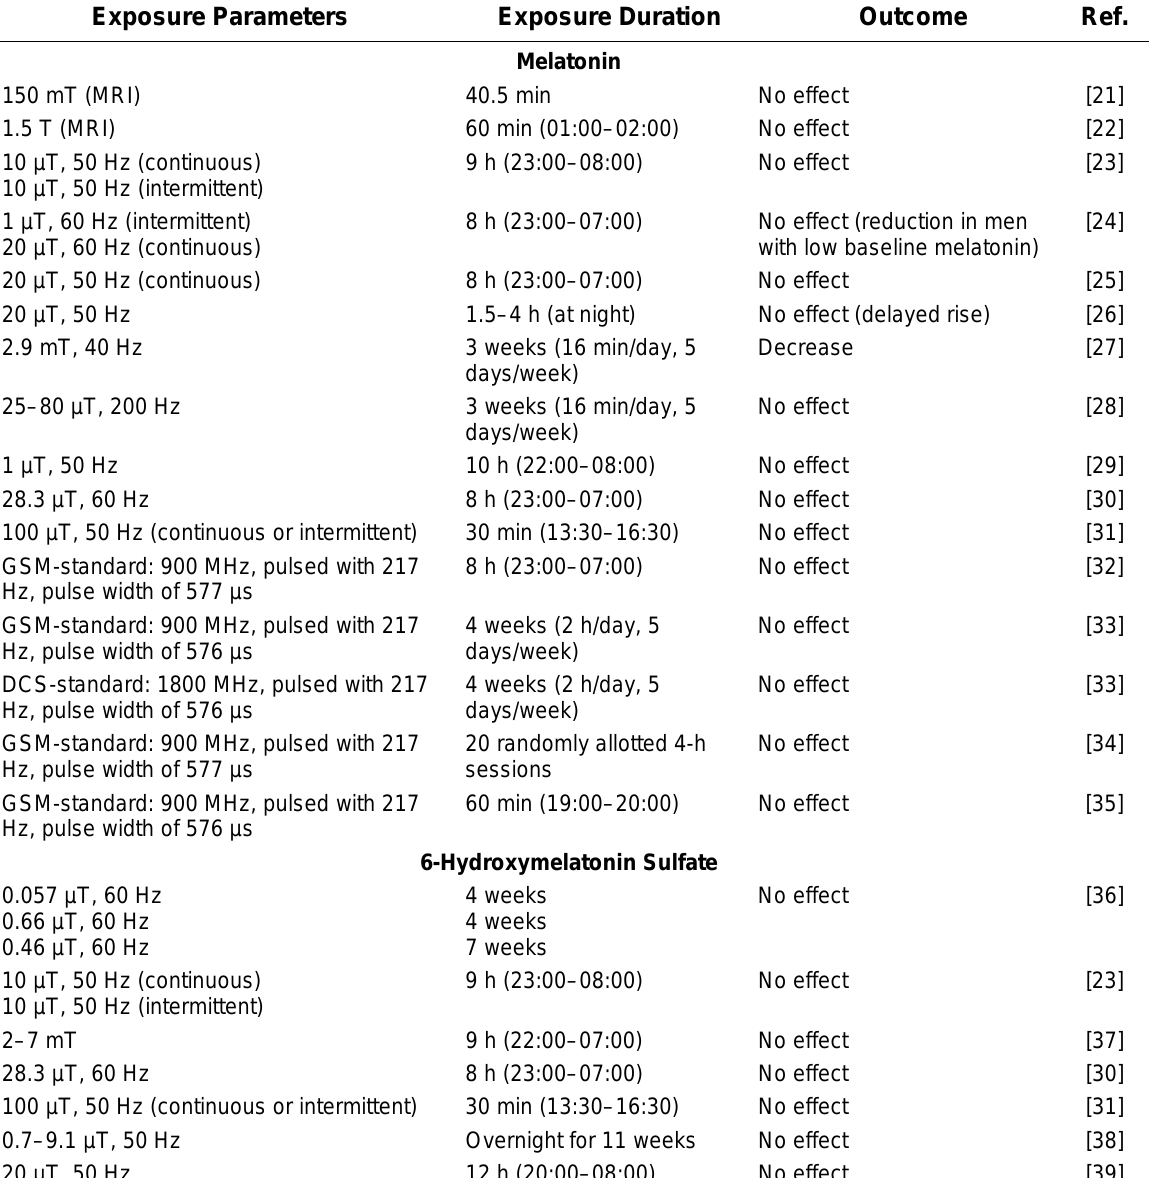
Effects of Electromagnetic Fields on Melatonin or 6-Hydroxymelatonin Sulfate (6-OHMS) Concentrations in Humans[40,